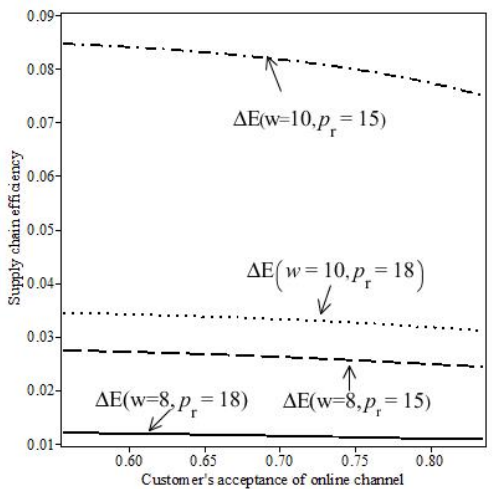
Figure 5. The difference of efficiency between Mechanisms 3 and 1.